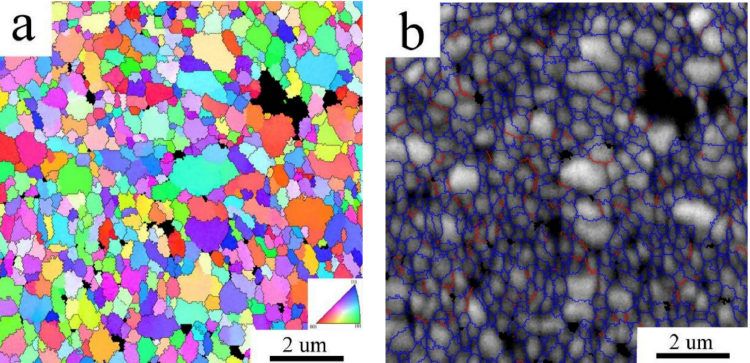
Figure 8. The EBSD micrograph of the Al7075_MC compact, ( a ) inverse pole figures; ( b ) distribution of grain boundaries, boundaries with misorientation angles above 15 ◦ in blue, boundaries between 5 ◦ and 15 ◦ in red.